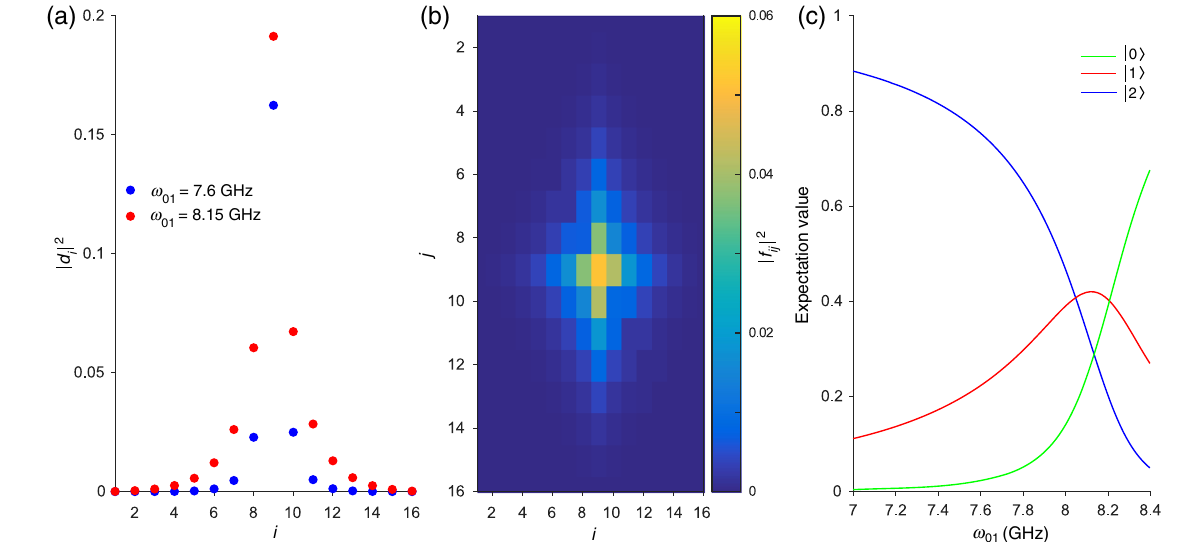
2 for ω 8 . 15 GHz as a function of position. (b) Plot of j f 01 ¼ i j